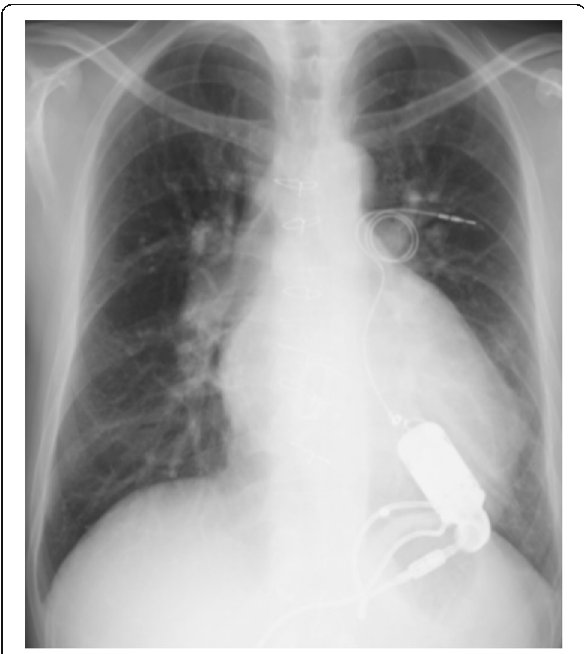
Fig. 3 Chest radiography on postoperative day 90 shows a reduced ventricular shadow and the ventricular assist device